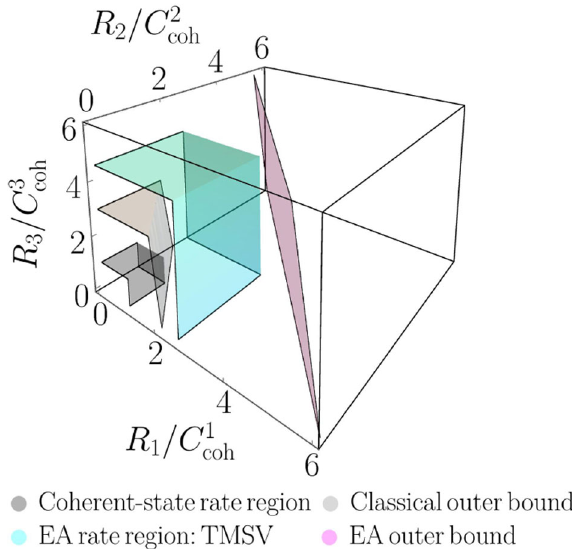
Fig. 5 The three-sender EA rate region. The rates are normalized , C 2 , and C 3 de fi ned in Ineq. (8), by the coherent state bounds C 1 coh coh coh evaluated in the scenario of microwave domain N S,1 = N S,2 = 0.1, N S,3 = 0.01, τ = 0.01, N B = 20, η 1 = η 2 = η 3 = 1/3. The EA rate region in Ineq. (4) (cyan), evaluated on TMSV states, is bounded by the EA outer bound (magenta) in Ineqs. (11) and (10); while the coherent- state rate region (black) given by Ineq. (8) is bounded by the classical outer bound (light gray).